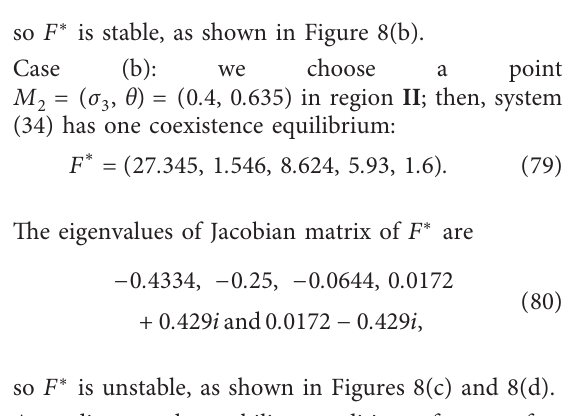
Figure 6: Choose σ � 0 . 4, and the other parameter values are given in (22). (a) When θ � 0 . 48, E 1 θ � 0 . 50, E ∗ ( 11 . 560 , 1 . 598 , 7 . 543 , 6 . 993 ) is LAS. (c) When θ � 0 . 55, E ∗ ( 69 . 131 , 1 . 409 , 13 . 895 , 11 . 962 ) is unstable. (d) When θ � 0 . 55, the 3D phase portrait depicts TCs, ECs, and